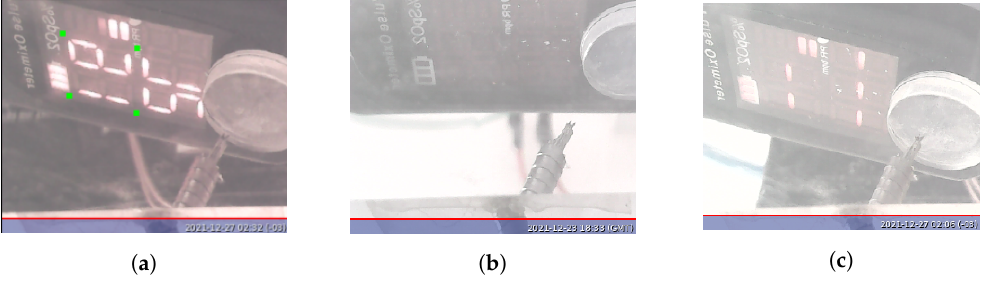
Figure 4. Possible states of the oximeter display. ( a ) Complete reading procedure and points (in green) needed for the oximeter image alignment; ( b ) oximeter turned off; ( c ) incomplete reading procedure.